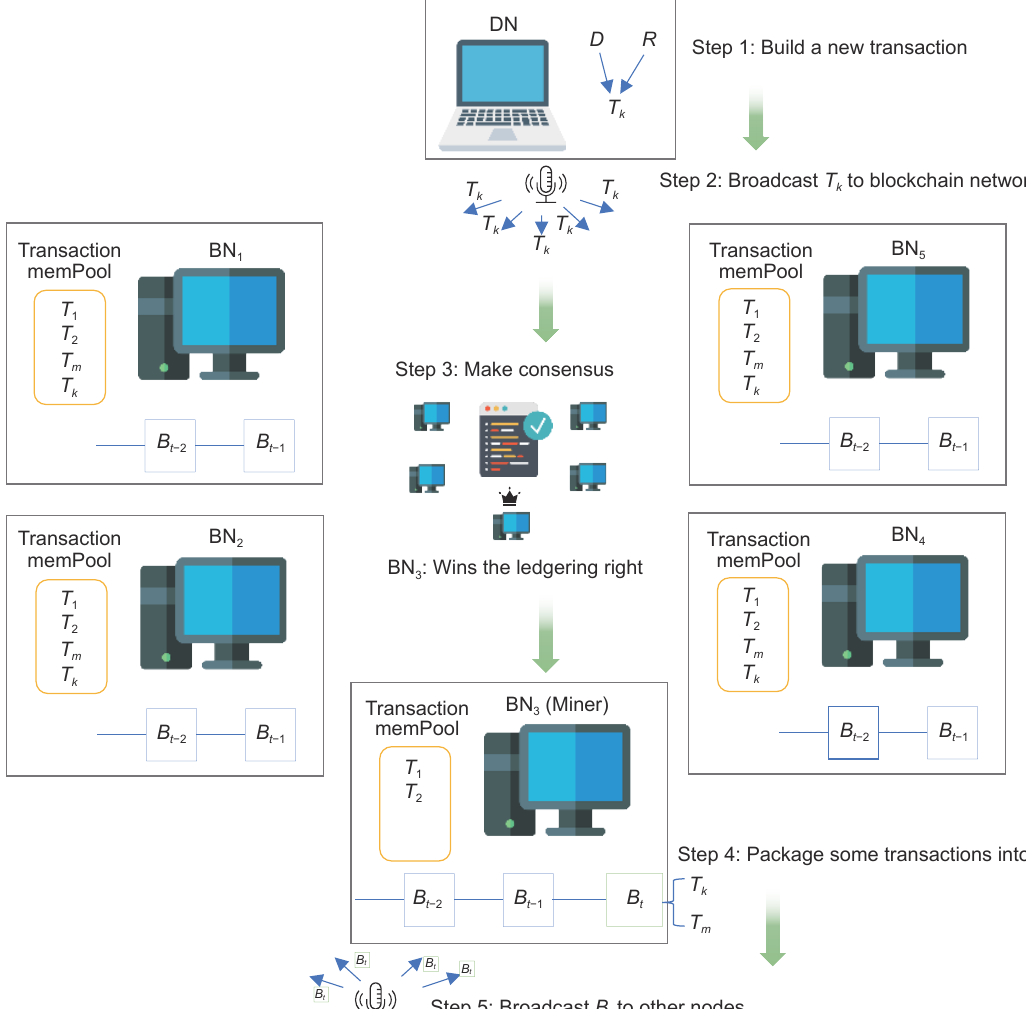
Fig. 6 A typical data processing flow in blockchain